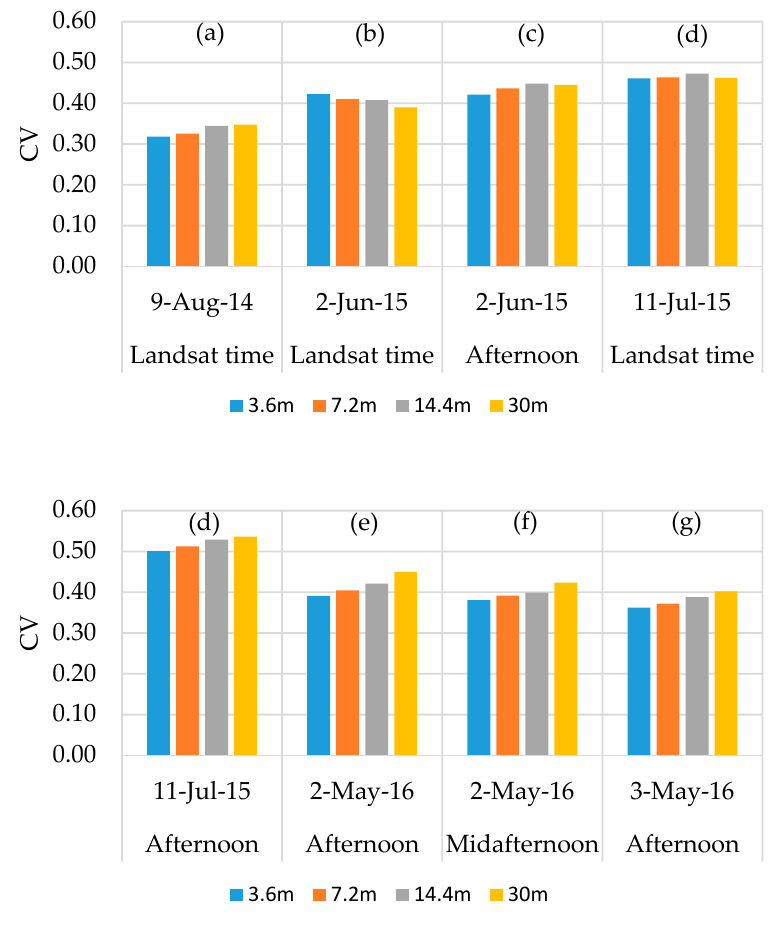
Figure 13. Spatial domain effect on the coefficient of variation ( CV ) of LE spatial data at different times.